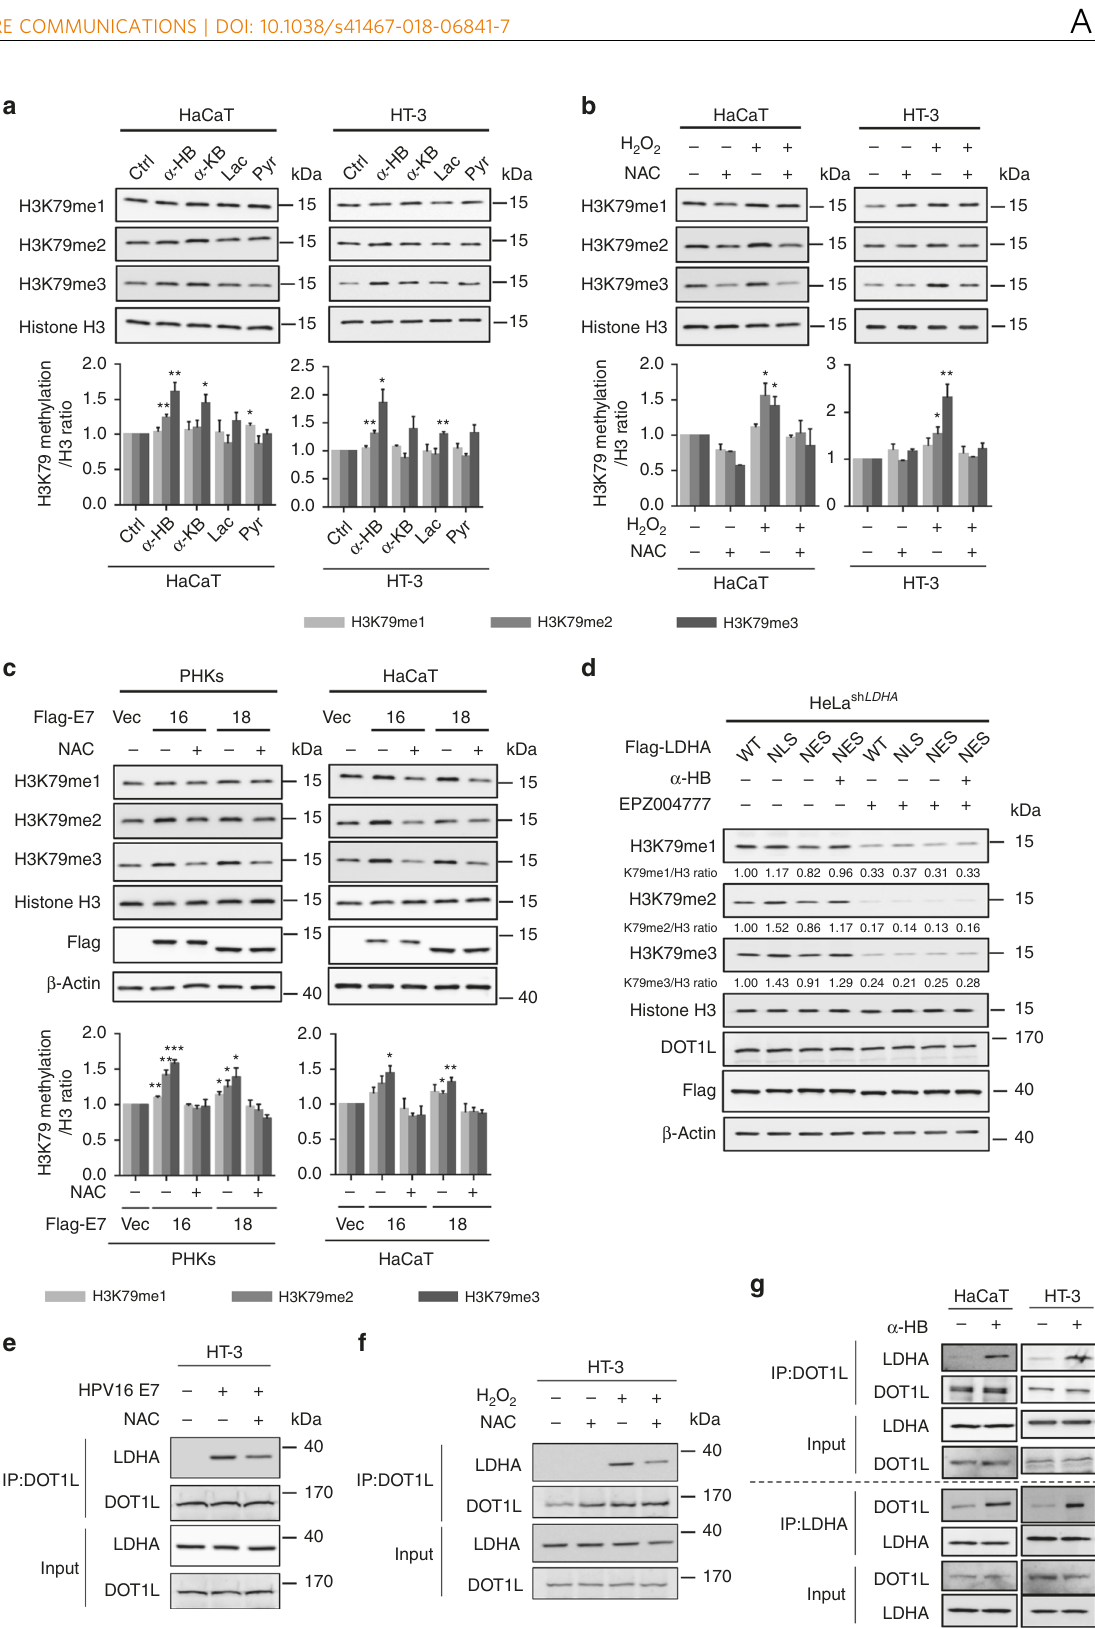
regulated cellular antioxidant responses or cell proliferation, seven antioxidant genes and three Wnt target genes were sub- jected to qPCR analysis. As expected, HPV16 E7 expression and H 2 O 2 treatment increased the expression of the majority of these genes, which was blocked by NAC (Fig. 5a and Supplementary